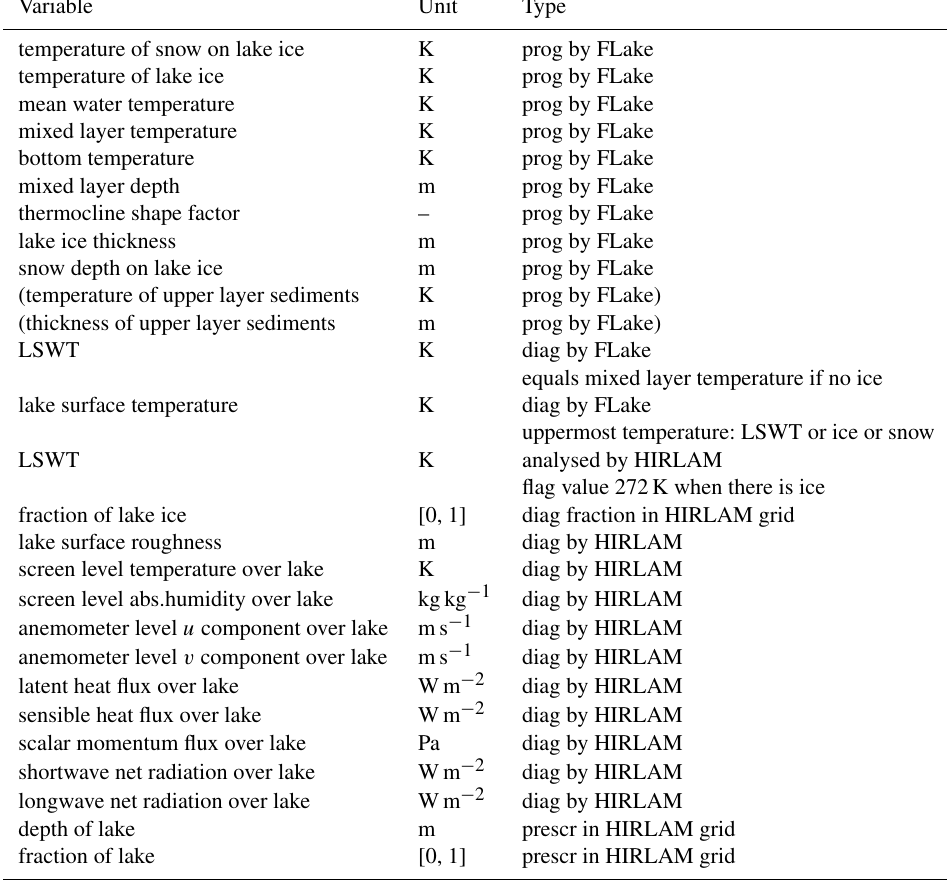
Table A1. Prognostic and diagnostic lake variables within HIRLAM.